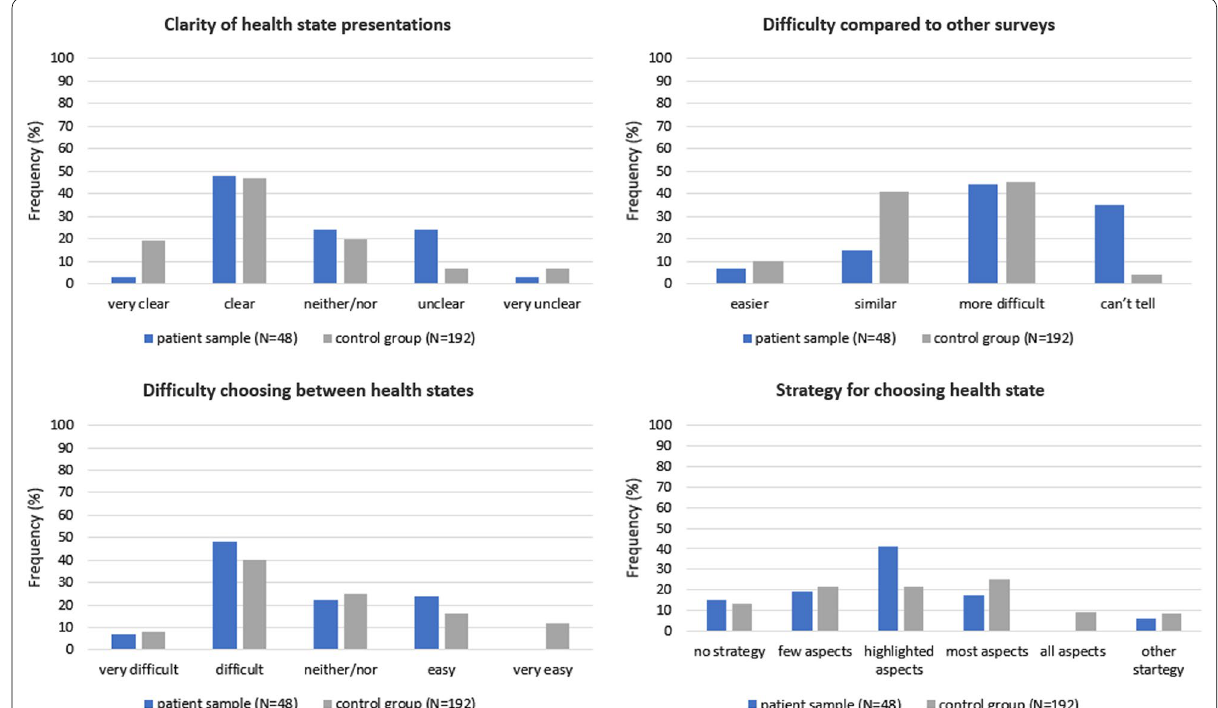
Fig. 4 Results from the QLU‑C10D valuation survey feedback questions. The results from the feedback questions of the QLU‑C10D valuation survey. Whereas differences between cancer patients (N difficulty compared to other surveys (i.e. judgement and response) was significant ( p the perceived difficulty when choosing between two health states ( p